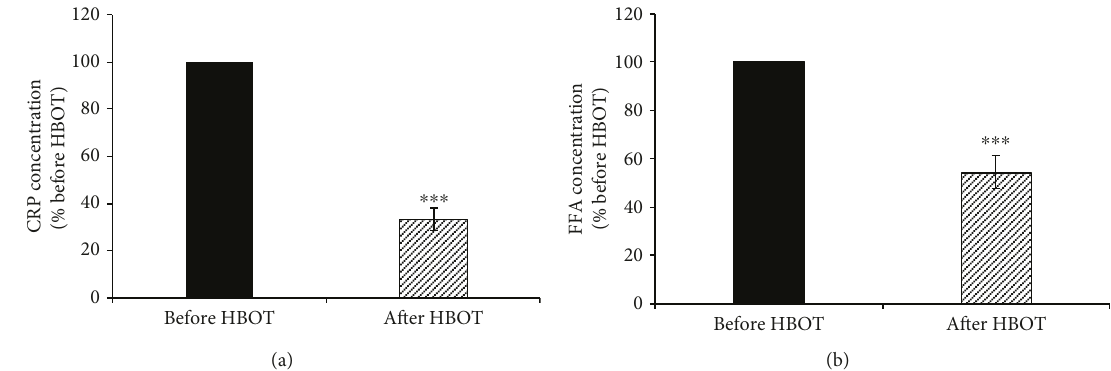
Figure 1: E ff ects of HBOT on plasma CRP and FFA levels. (a) The plasma level of CRP; (b) the plasma level of FFA. Results are expressed as % of the value obtained before HBOT and represent mean ± SEM ( n = 15 ); ∗∗∗ p < 0 001 . CRP: C-reactive protein; FFA: free fatty acid. Other abbreviations are under Table 1.